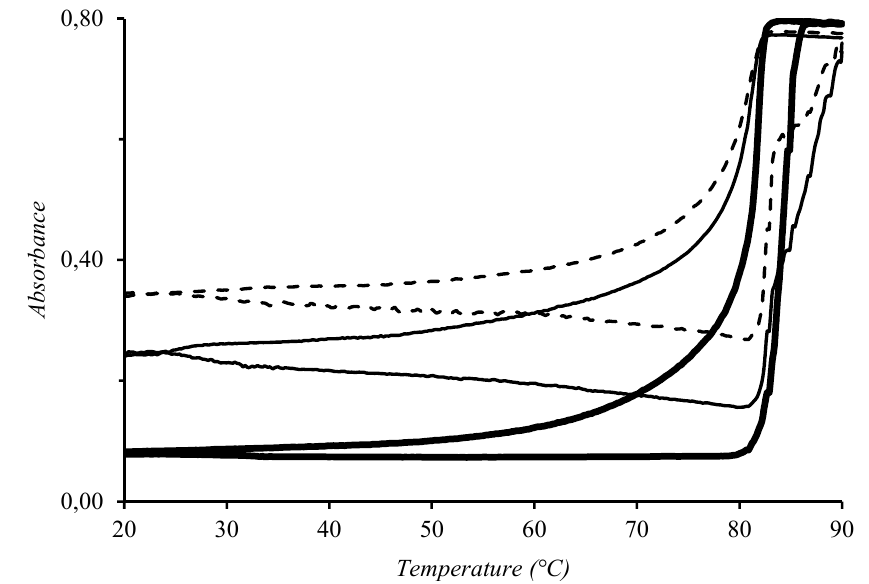
Figure 3. Absorbance at 260 nm as a function of temperature during assembly and disassembly cycle of complementary AuNP-DNA (AuNP-T10-DNAA AuNP-T10-DNAT ) recorded using three different heating/cooling rates: 1 °C/min 11 (dashed line); 0.5 °C/min (solid line); 0.1 °C/min (bold